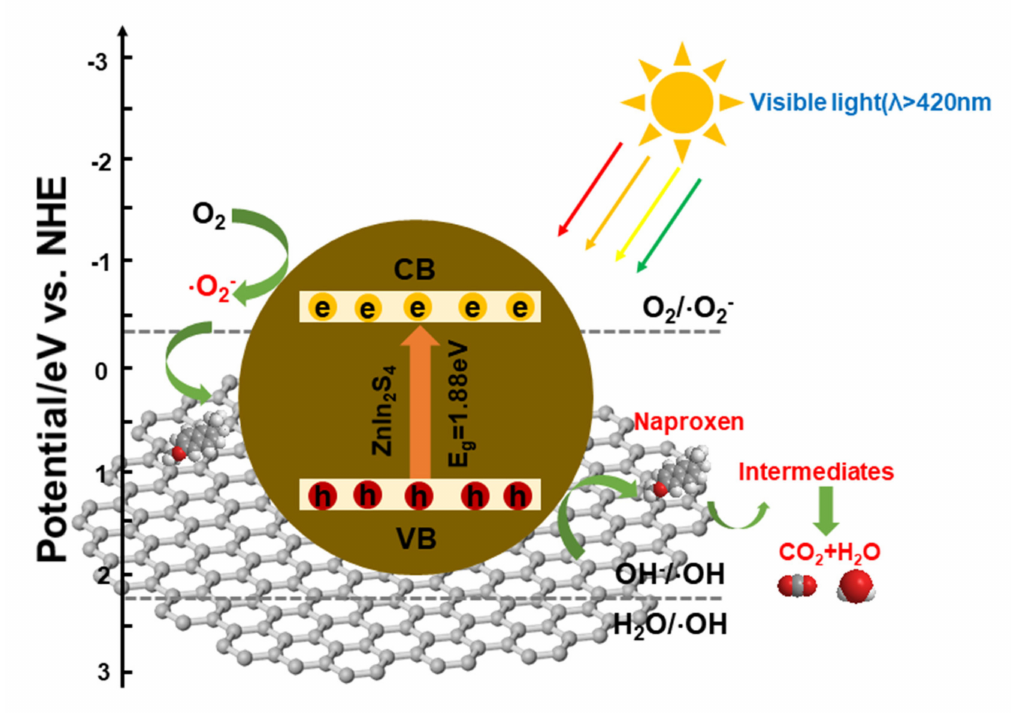
Figure 7. Schematic illustration for photogenerated carriers transfers and photocatalytic mechanism of rGO / ZIS composites under visible-light irradiation ( λ > 420 nm).